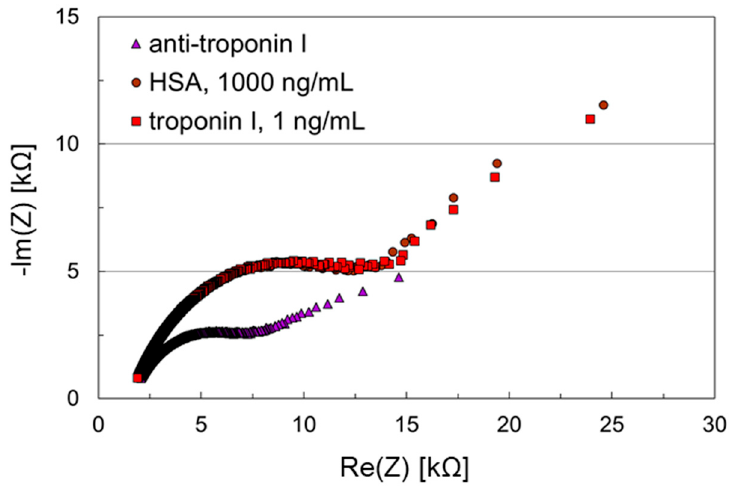
Figure 5. Nyquist plots of an impedance biosensor chip with aromatic hydrocarbon-based SAM for troponin I detection. The working electrode was coated with anti-troponin I, which was immobilized on a SAM consisting of 4-mercaptobenzoic acid. The counter electrode was coated with 1,4-benzenedithiol. Samples containing HSA, 1000 ng/mL, and troponin I, 1 ng/mL, were applied subsequently to the biosensor chip.